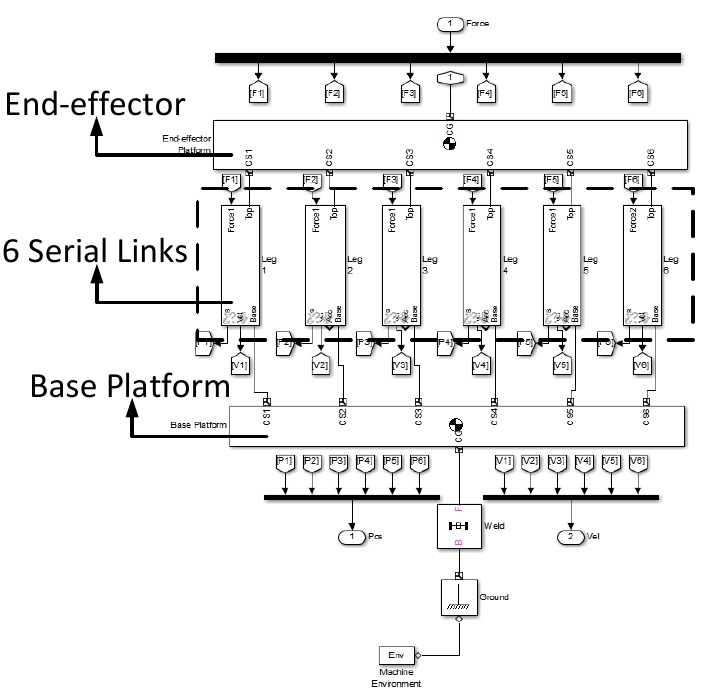
Figure 5. Mechanical model of 6-RSS parallel robot built by SimMechanics.